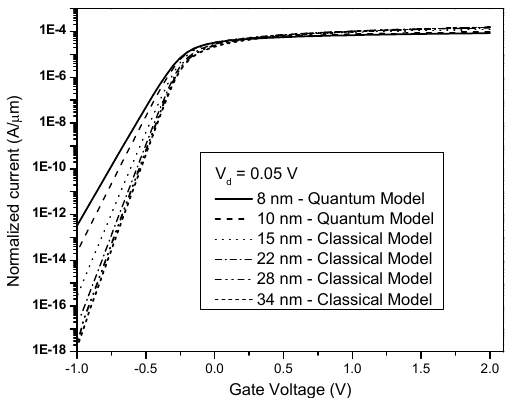
Figure 4. Transfer Characteristics at V D = 0.05 V for various channel lengths. By sweeping the gate voltage at V D = 0.05 V, the following observation can be made: The off-current increases when channel length decreases, while the on-current saturates independent of channel length. Accordingly, we extract the off-current values across var- ious channel lengths, which are shown in Figure 5. Figure 5. Normalized off-current (in A/µm) vs. channel length (in nm). This plot shows that off- current increases with a decrease in channel length as a result of poor gate control. This is hypothesized to be a consequence of poor gate control when the channel length is scaled down from 34 nm to 8 nm leading to increased leakage in the sub-thresh- old region. From Figure 5, we observe that the scaling of the off-current is disproportional to the channel length, which suggests that the off-current at lower drain voltage is contact lim- ited. This is confirmed to be Schottky limited from the band profile of the transistor. Since the interface between Ni-contact and multilayer MoS 2 has a barrier height of 0.45 eV in the junction, there is an abrupt change at the interface, confirming Schottky-type contact. The non-linear dependence of the drain current at a lower VD of 0.05 V suggests that the current is limited by the Schottky barrier at contacts for various gate voltages despite the accumulation of electrons in the channel (biased ON state). This confirms that the off-